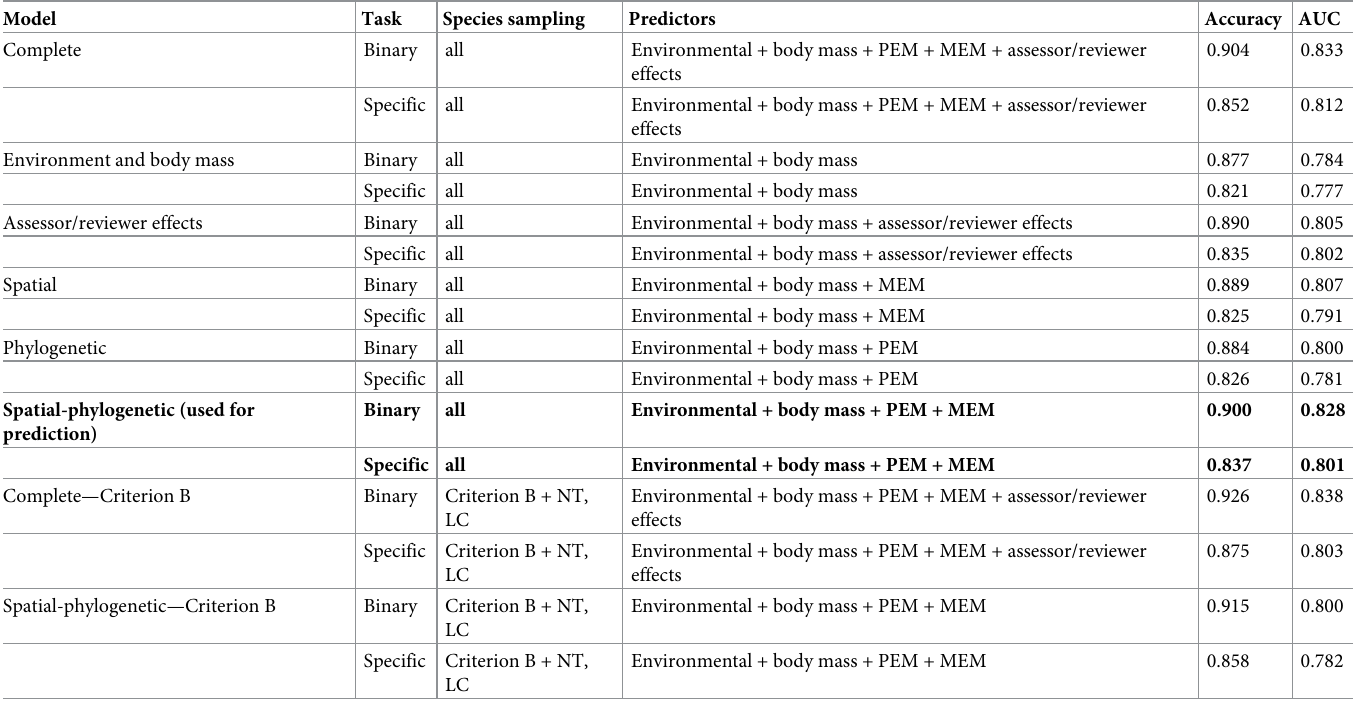
Table 1. Comparison of accuracy metrics of 8 automated assessment models for classifying reptile species into IUCN extinction risk